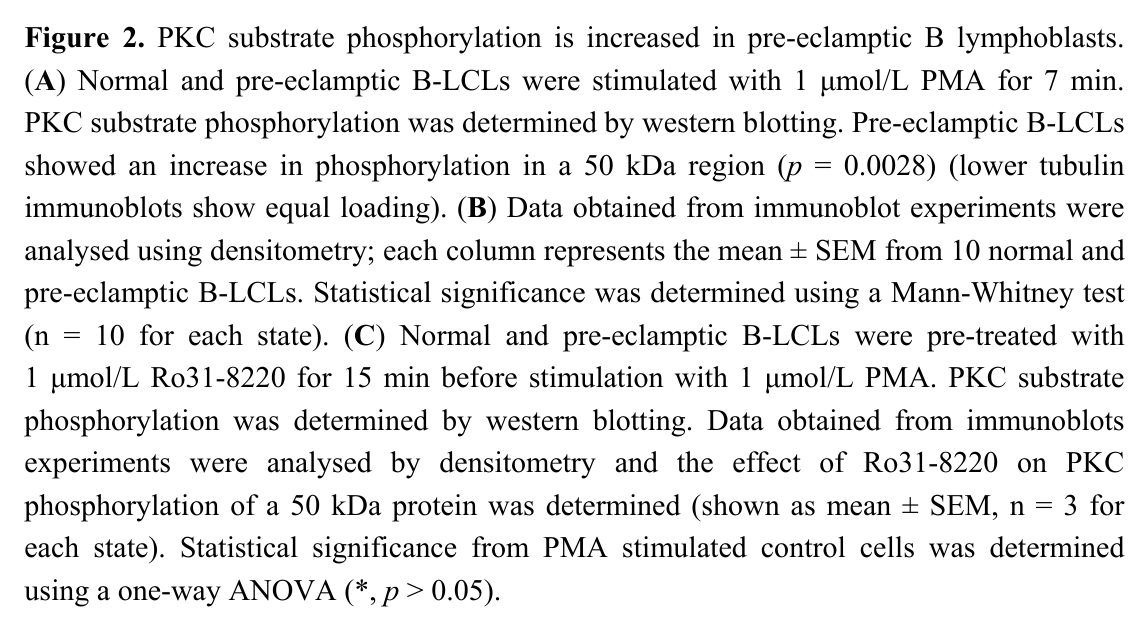
Figure 2. PKC substrate phosphorylation is increased in pre-eclamptic B lymphoblasts. ( A ) Normal and pre-eclamptic B-LCLs were stimulated with 1 μ mol/L PMA for 7